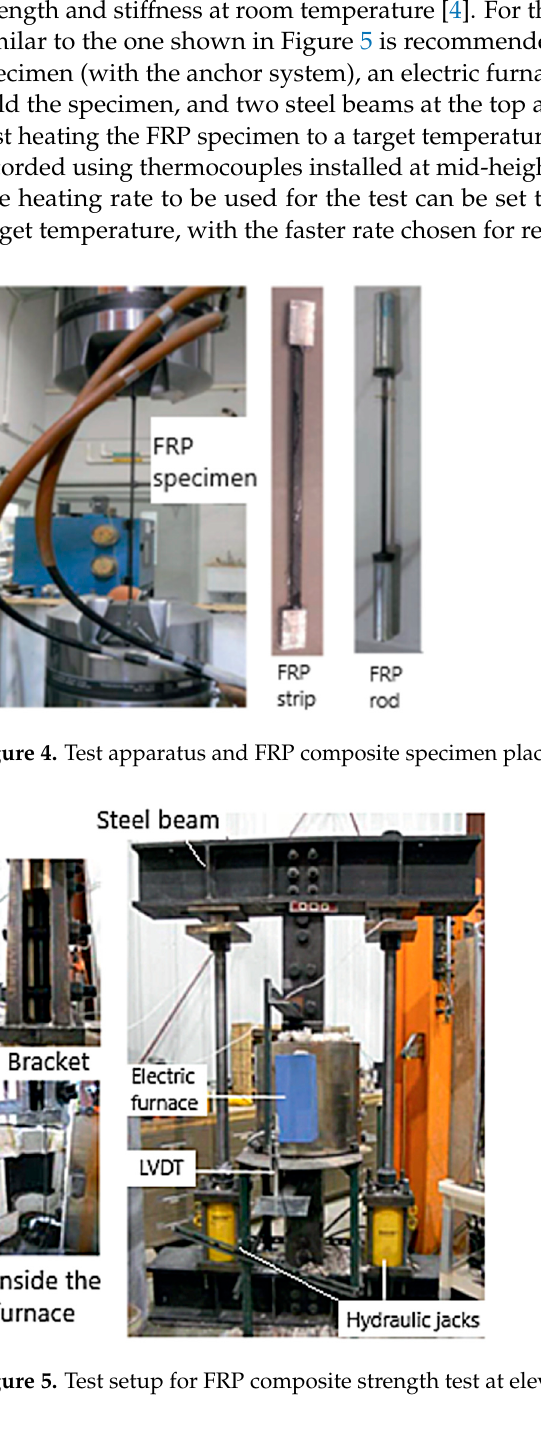
( d ) Figure 3. Fabrication of anchor system for FRP specimens indicating ( a ) epoxy filling, ( b ) steel wires, ( c ) steel frame, and ( d ) test specimen.